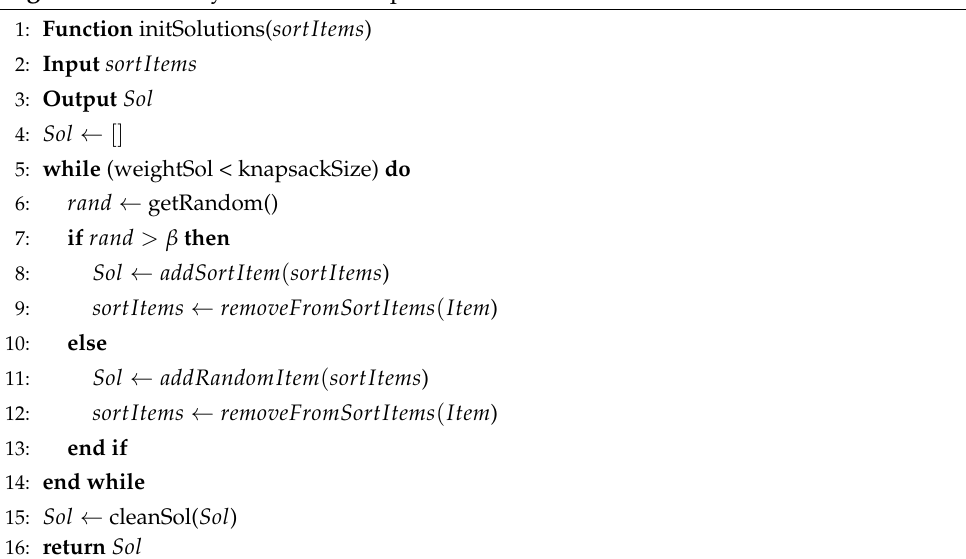
Algorithm 1 Greedy initialization